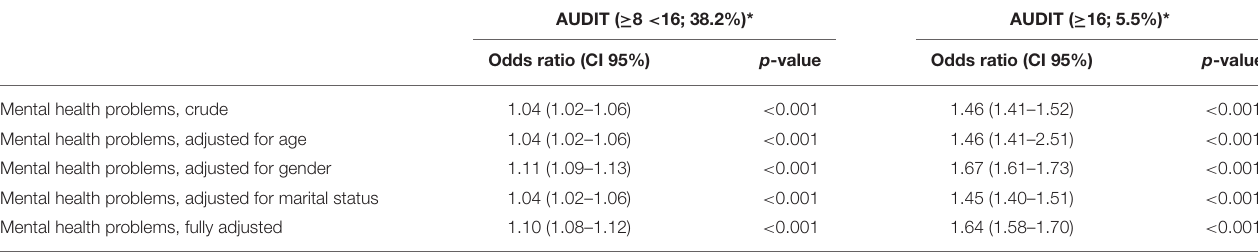
Logistic regression models. N = 48,886. * AUDIT < 8 represents the low risk